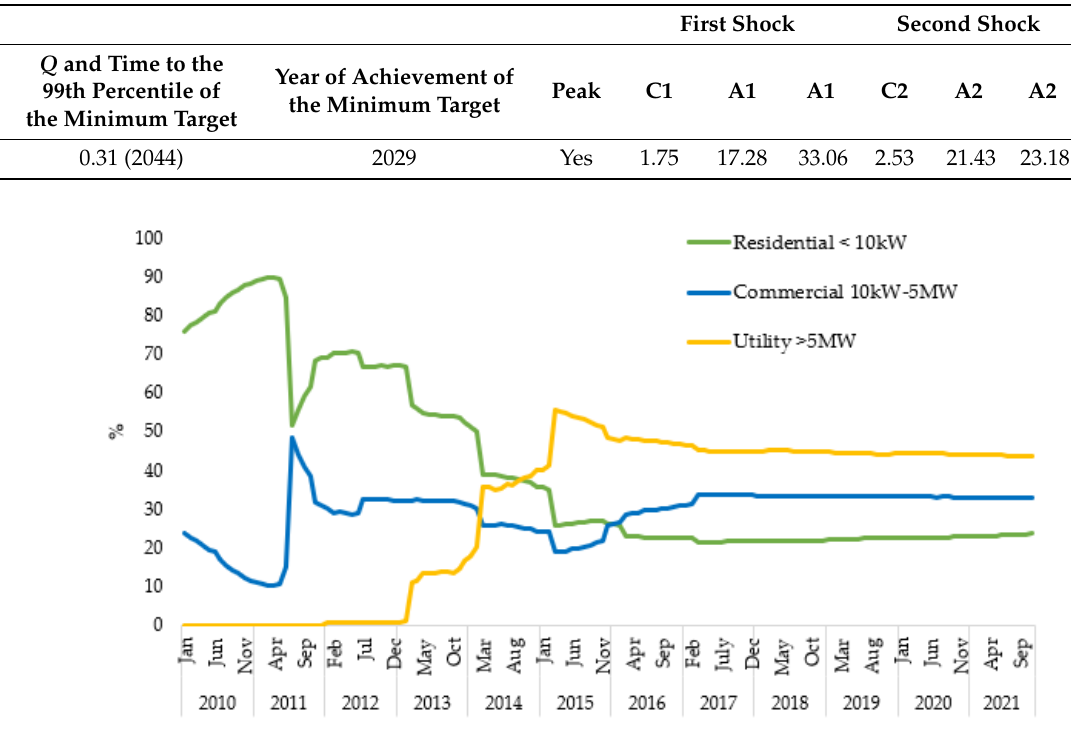
Figure A3. Monthly share in total cumulative installed capacity by sector: residential (green), com- mercial (orange), and Utility (purple) from January 2010 to November 2021. Own calculation based on data from [27].